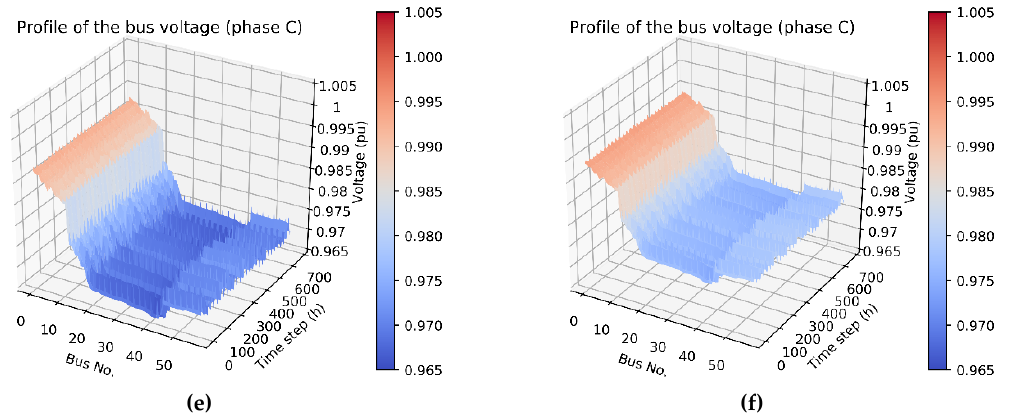
Figure 15. Bus voltage profiles: ( a ) phase A: before rephasing, ( b ) phase A: after rephasing, ( c ) phase B: before rephasing, ( d ) phase B: after rephasing, ( e ) phase C: before rephasing, and ( f ) phase C: after rephasing.